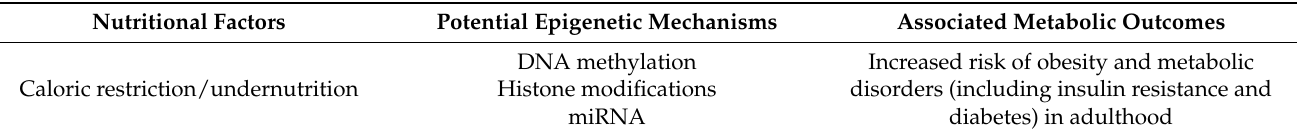
Table 3. Key dietary factors with associated epigenetic metabolic